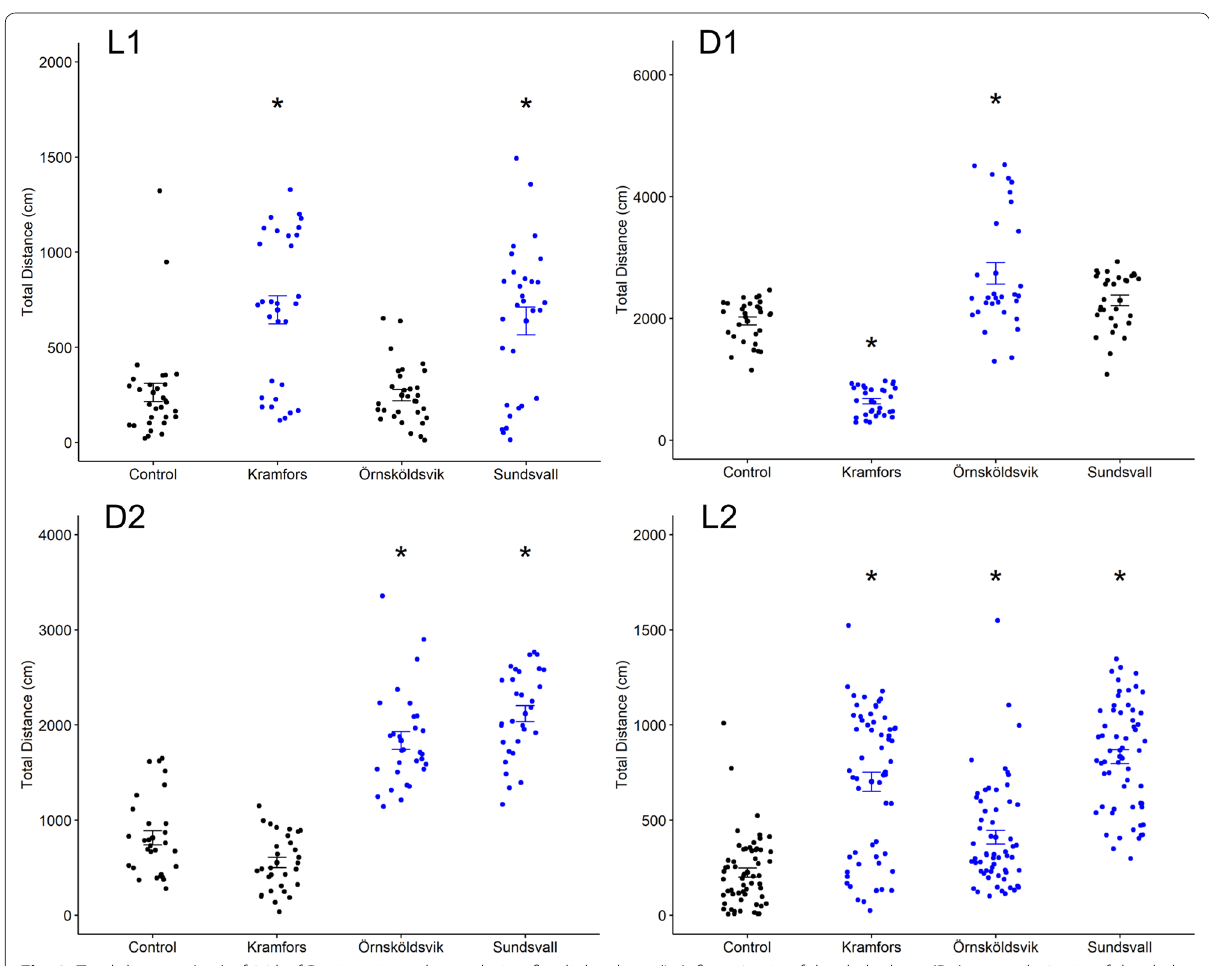
Fig. 3 Total distance (cm) of 96 hpf Danio rerio embryos during first light phase (L1), first 10 min of the dark phase (D1), second 10 min of the dark phase (D2) and second light phase (L2). Single dots represent the summed total distance of 16 embryos during each light/dark phase. The blue data sets market with * highlights statistical differences between control and treatments ( p confidence intervals